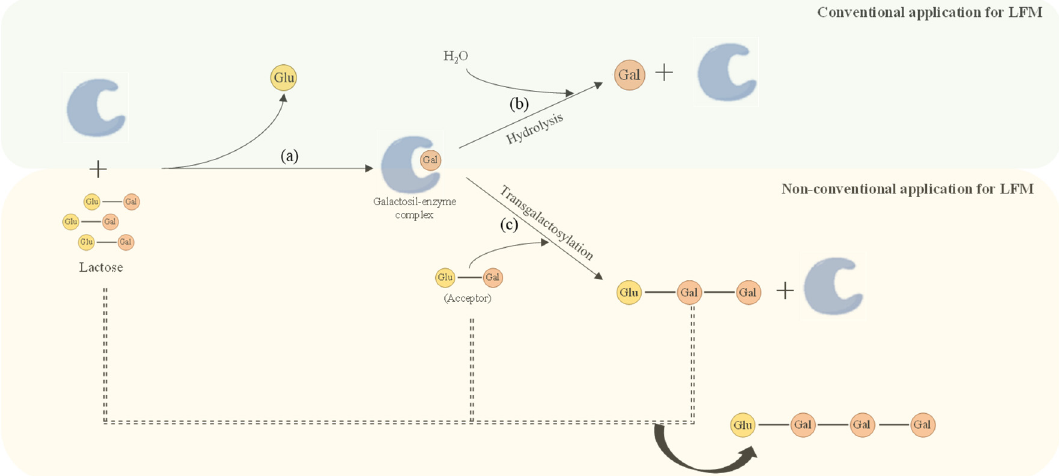
Figure 3. Catalytic mechanism of the β -galactosidase enzyme with lactose as substrate: ( a ) enzyme– galactosyl complex formation; ( b ) hydrolytic reaction; ( c ) transgalactosylation mechanism. Glu: Glucose; Gal: Galactose; LFM: Lactose-free Milk.